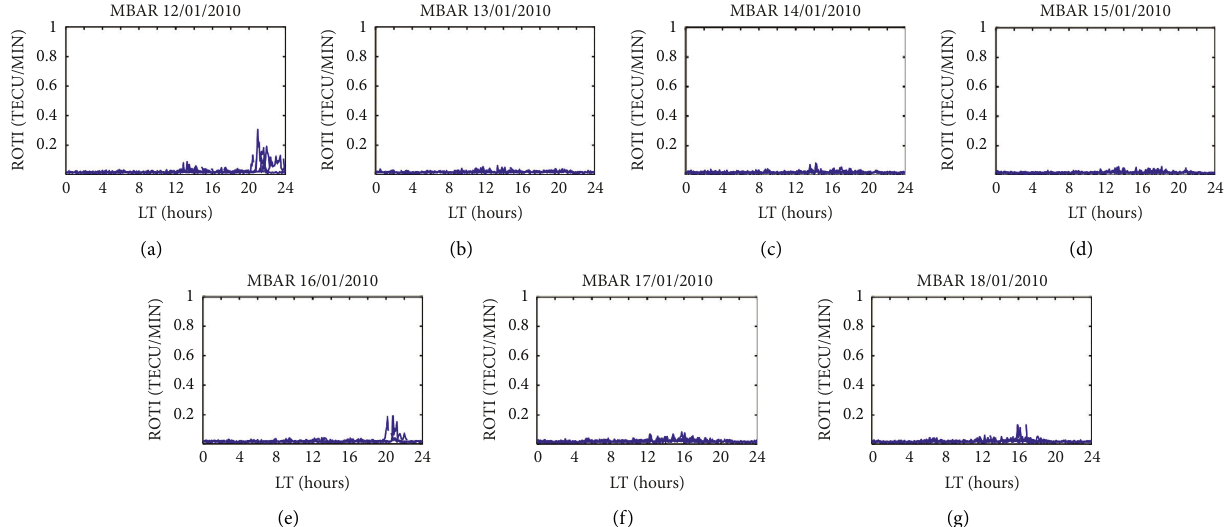
Figure 15: ROTI against LTover MBAR station for (a) 12 th January 2010, (b) 13 th January 2010, (c) 14 th January 2010, (d) 15 th January 2010,